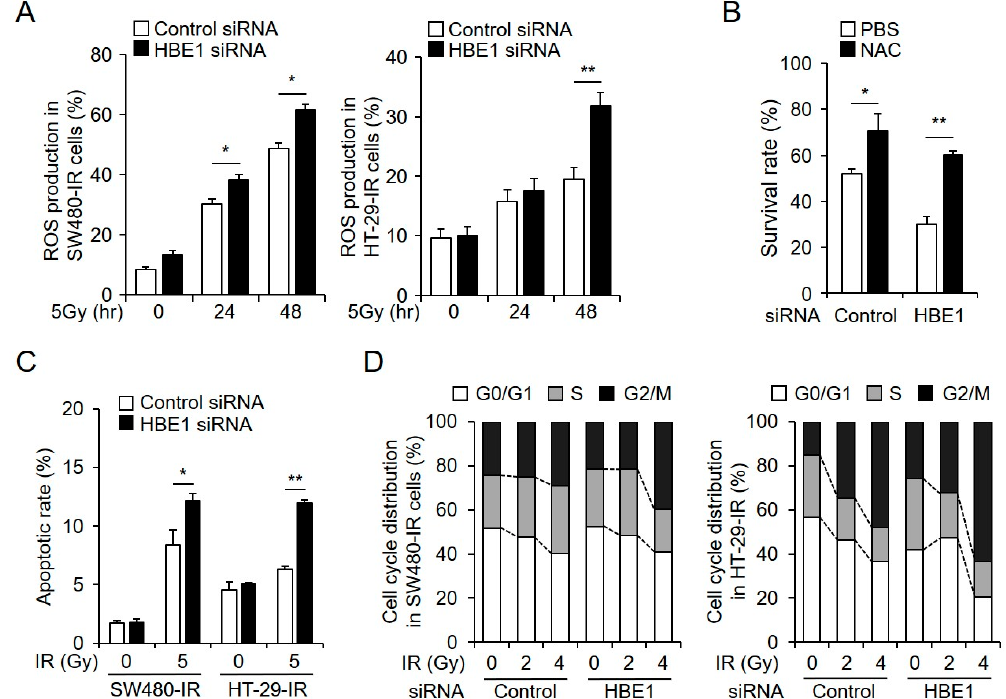
Figure 6. HBE1-deficiency in radiation-resistant cells increases radiation sensitivity through increased reactive oxygen species (ROS) production and cell cycle arrest. After transfecting SW480-IR and HT-29-IR cells with control or HBE1 siRNA in the presence or absence of radiation (5 Gy) exposure, ROS production and the expression of HBE1 were measured by real-time PCR. ( A ) Intracellular ROS levels were analyzed by flow cytometry using CM-H2DCFDA for the indicated times, compared to those in the corresponding controls * p < 0.05, ** p < 0.01. ( B ) Bar graph showing that HBE1 depletion via HBE1 siRNA decreases the survival rate, as determined by a clonogenic assay, after 14 days. Cells were pre-treated with the antioxidant N-acetyl cysteine (NAC). * p < 0.05, ** p < 0.01 ( C ) Ionizing radiation (IR)-resistant cells were transfected with control or HBE1 siRNA and exposed to 5 Gy irradiation. Forty-eight hours later, the apoptotic rate was determined by FACS analysis based on annexin V staining. * p < 0.05, ** p < 0.01. ( D ) After exposure to radiation (5 Gy) for 24 h, cell cycle arrest at G2 / M in SW480-IR and HT-29-IR cells transfected with control or HBE1 siRNA was analyzed by